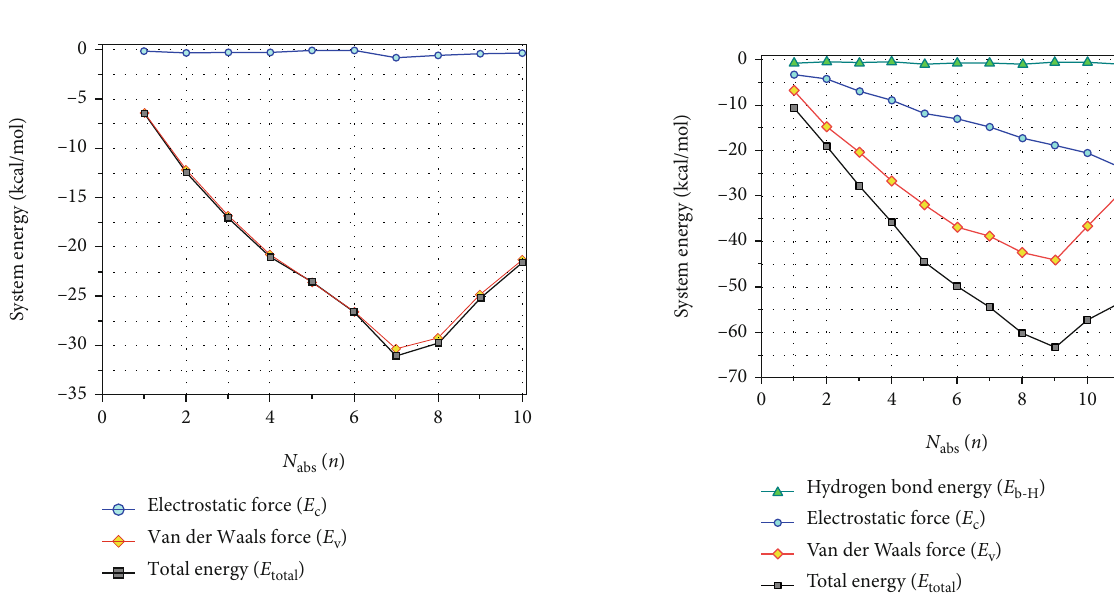
Figure 5: Saturated adsorption con fi guration of CH yellow.